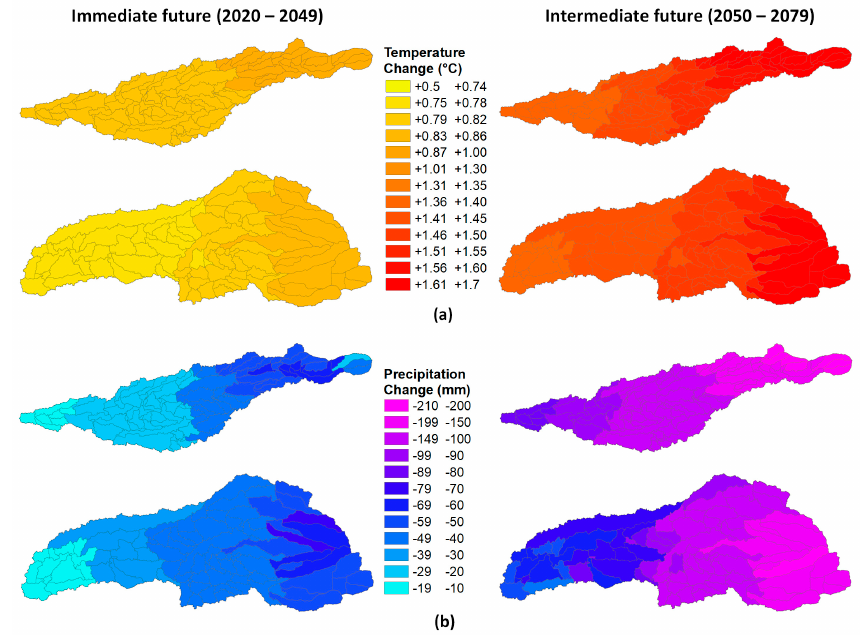
Figure 5. Changes in the yearly average ( a ) temperature and ( b ) precipitation at the sub-basin scale, using RegCM4-MPI-ESM-MR, scenario RCP8.5. Upper basin: Quino, lower basin Muco.